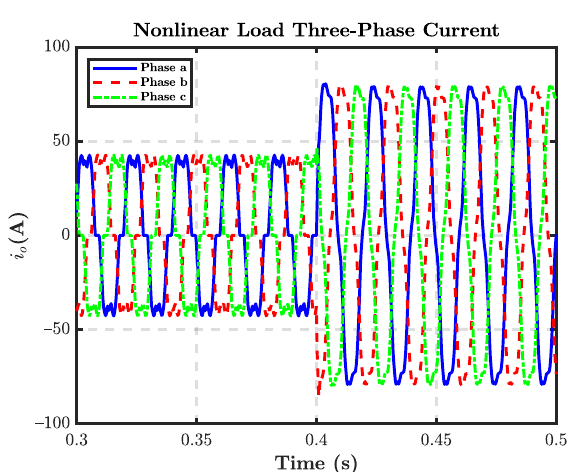
Figure 19. The second case study.